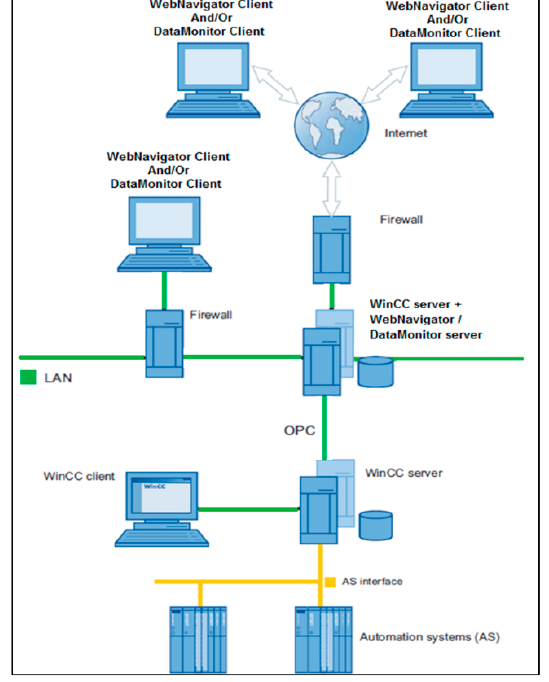
Figure 4. Exemplary structure of the network with Siemens solutions for remote access.